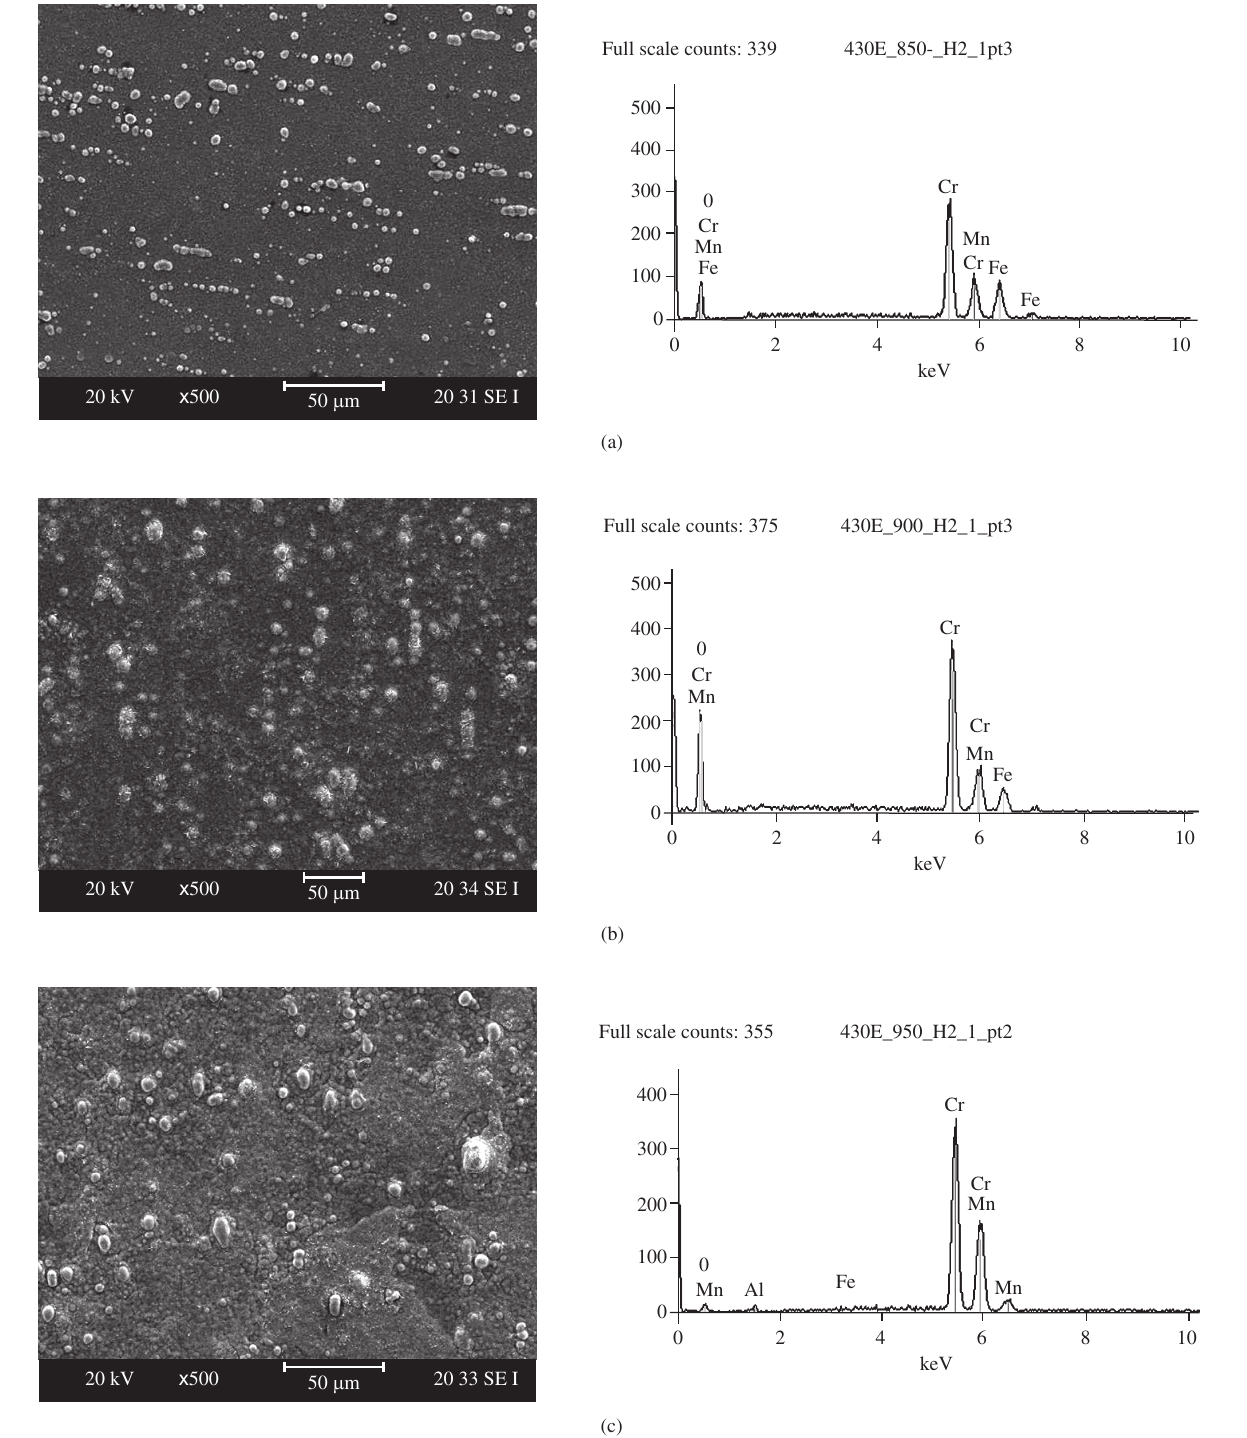
Figure 4. Microstructure and EDS analyses of the oxide films grown on the 430E steel. dition, other studies 8 show that the oxygen and chromium diffusivities noting that, at each temperature, there is a given oxygen partial pressure value. Our feeling is that the effect of the oxygen partial in Cr O do not depend on the oxygen pressure. As a general case, 2 3 the 430A and 430E stainless steel are used for applications at low pressure on the oxidation constant, between pO = 1.46 x 10 –20 and 2 1.3 x 10 –18 atm, should be negligible. Indeed, in previous studies 1,2 , or room temperature, and the knowledge of their oxidation kinetics it was observed that the oxidation constant of the AISI 439 ferritic at high temperatures is particularly important in the field of the hot steel did not practically show significant variation with the oxygen rolling. On the other hand, the 439 steel has been used for replacing pressure for the extreme values of 1 atm and 1.46 x 10 –20 atm. In ad- the 304 austenitic stainless steel for industrial applications at